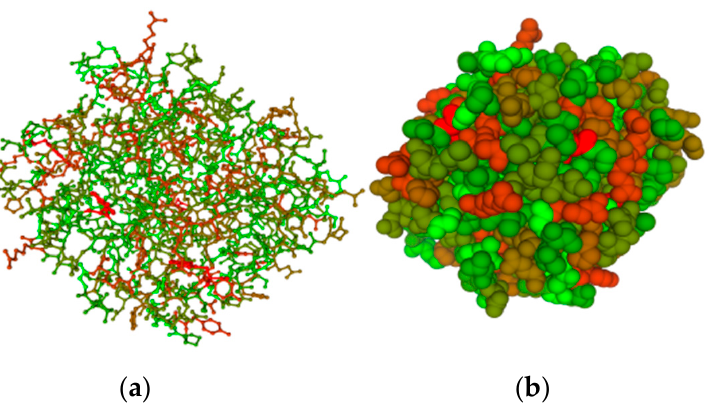
Figure 8. 3D model of the sialidase of O. paurometabola O129 obtained by SWISS-MODEL Workspace [27]. ( a ) “Ball and stick” presentation of the chain; ( b ) “Space-full” model.